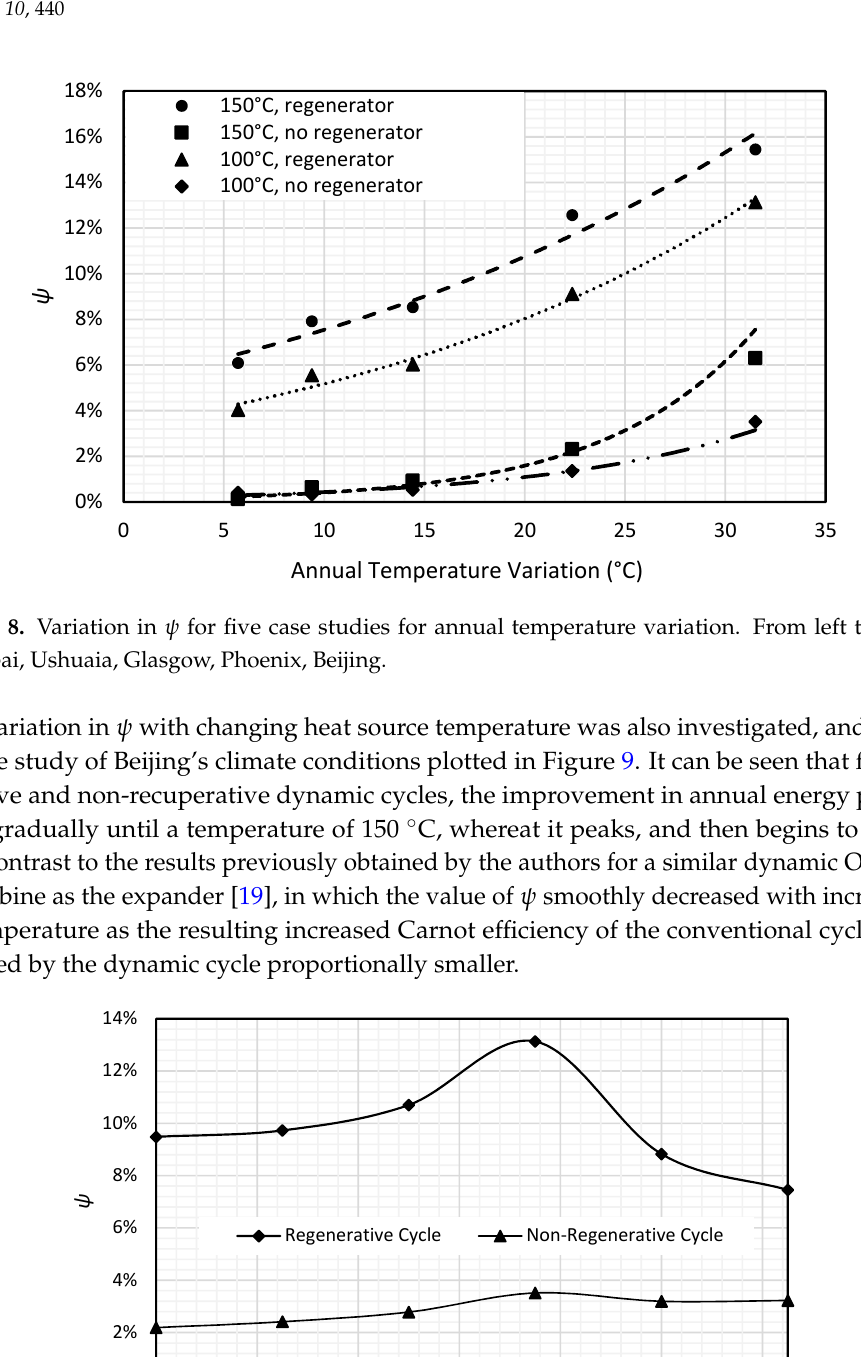
Figure 9. Variation in ψ with changing heat source temperature under Beijing’s ambient conditions.